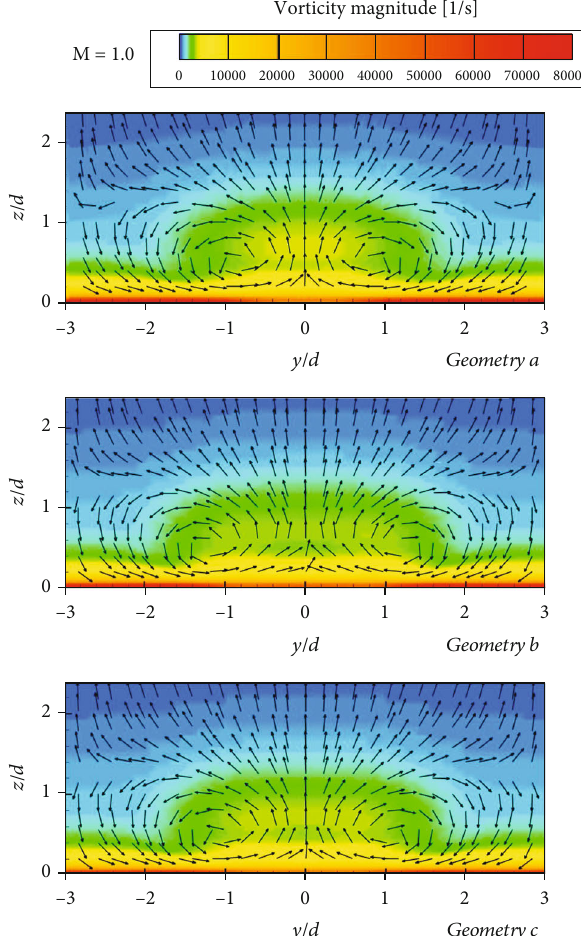
Figure 16: Vorticity magnitude contours and velocity vectors at x /d = 5 , for the three fi lm hole geometries, M = 0 : 5 .